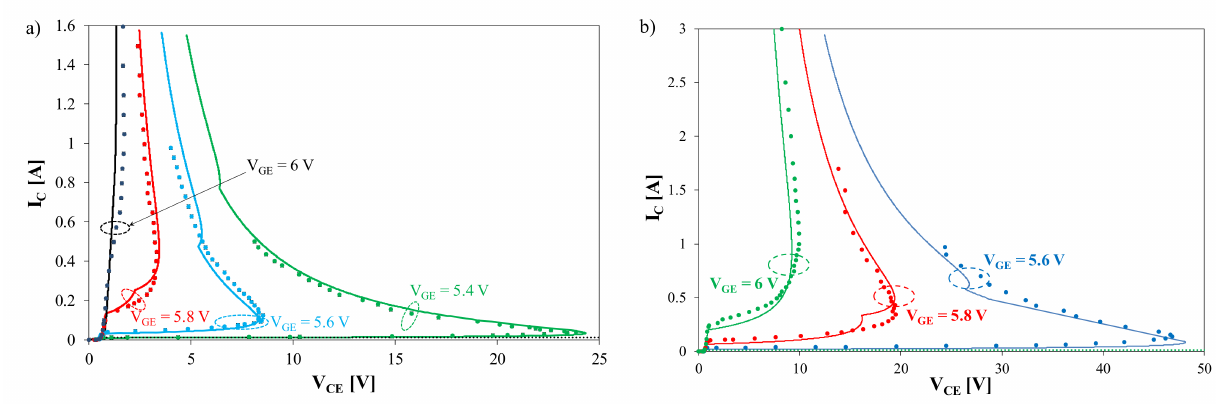
Figure 3. Computed and measured output characteristics of the IGBT of the type IRG4PC40UD operating without any heat-sink ( a ) and situated on the heat-sink ( b ).